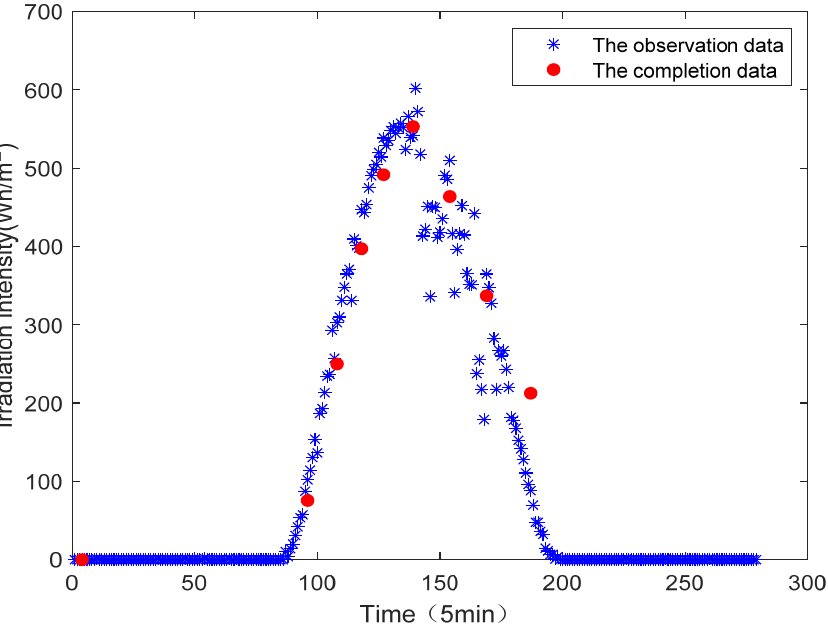
Figure 9. Recovered solar radiation data by matrix completion for one